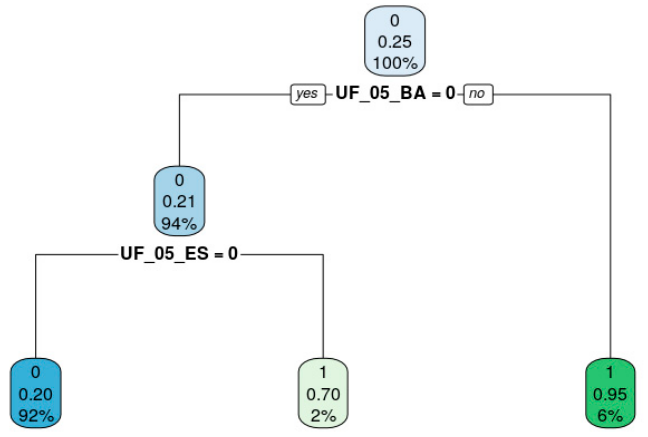
Figure 5. Decision